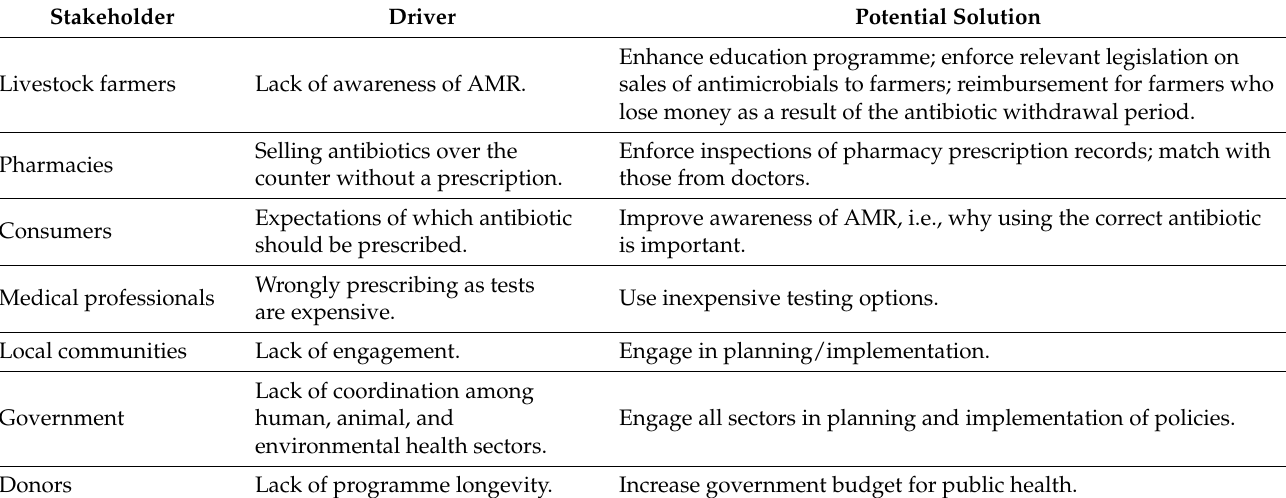
Table 1. Stakeholders, drivers, and